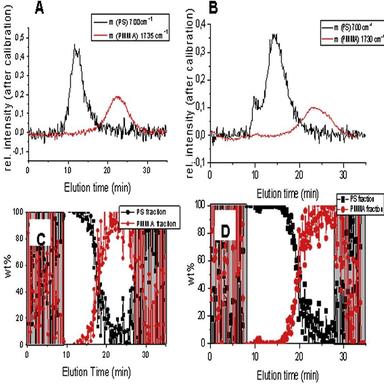
FTIR elution profiles and chemical composition as a function of elution time for PS and PMMA blends SM1 (A and C) and SM2 (B and D).